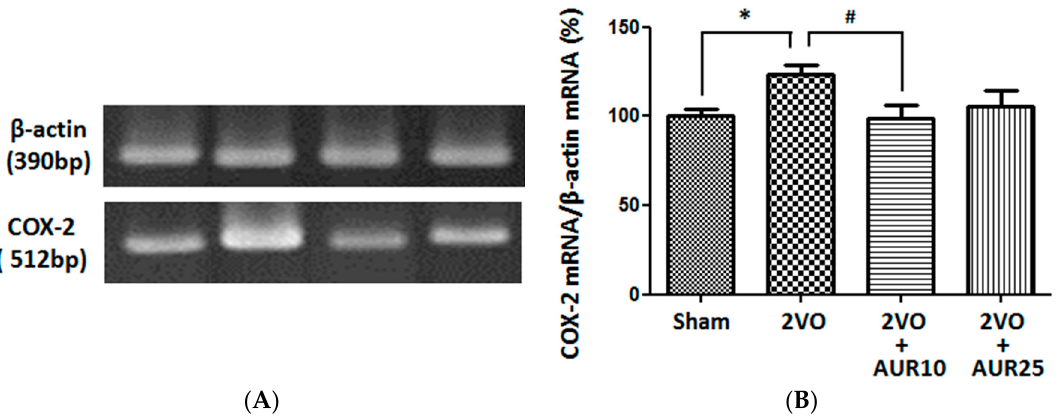
Figure 3. Effects of AUR on the expression of COX-2 mRNA in the hippocampus. ( A ) Densitometric patterns of COX-2 mRNA and β -actin mRNA bands; ( B ) Densitometric quantification of COX-2 mRNA band densities normalized by the density of the β -actin mRNA band. Values are the means ± SEM (5~6 for each group). * p < 0.05 and # p < 0.05, as indicated by the brackets.